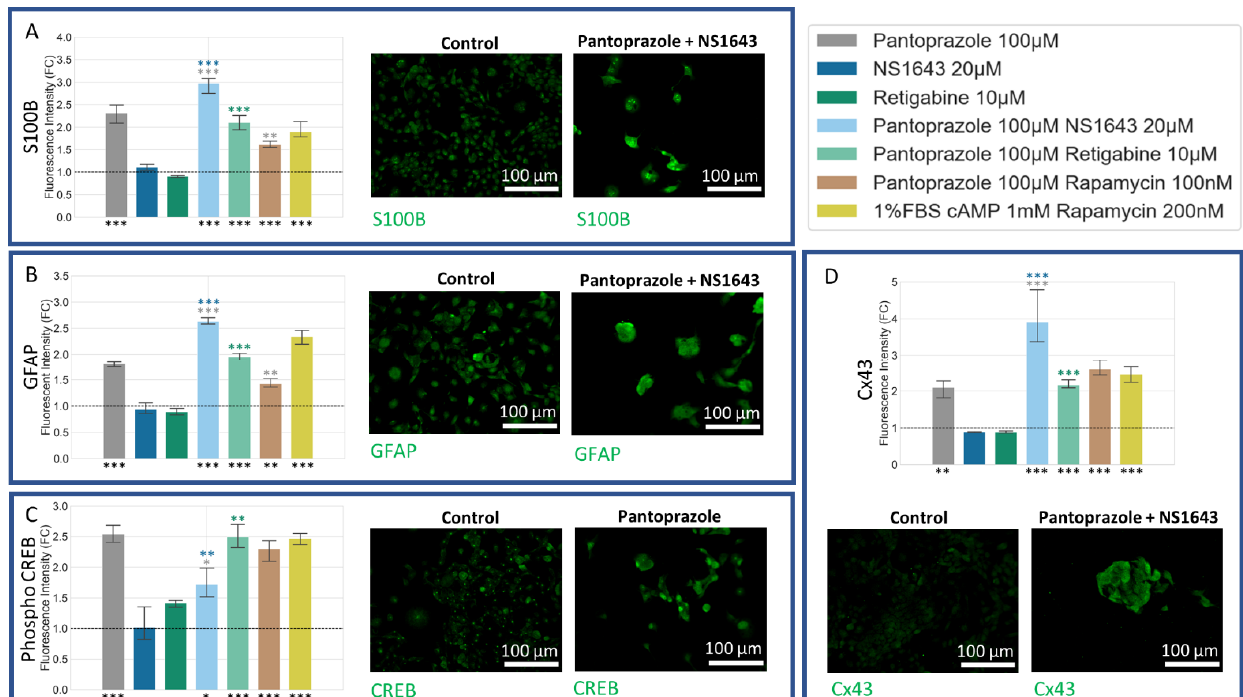
Figure 9. Differentiation Analysis of NG108-15 Cells Reveals that Treatments with Pantoprazole Increased Astrocytic and Differentiation Markers after 6 days. Immunofluorescence of cells was conducted and analyzed with CellProfiler and measured for integrated fluorescence intensity. ( A ) Stain of S100 calcium-binding protein B (S100B). ( B ) Stain Glial Fibrillary Acidic Protein (GFAP). ( C ) Stain of the phosphorylated cAMP-Response Element Binding Protein (Phospho CREB). ( D ) Stain of Connexin 43 (Cx43). Treatments corresponding to the colored bars are outlined in the figure itself. The log of the fold change in intensity was compared between single treatments and combined treatments, except the positive control, with significant values shown in the color of the treatment compared. The initial fluorescence intensities were compared to their corresponding control, with significant values shown under the bars as, ***: p < 0.001, **: p < 0.01, * : p < 0.05 (one-way ANOVA with Tukey post hoc analysis n > 3 technical replicates).